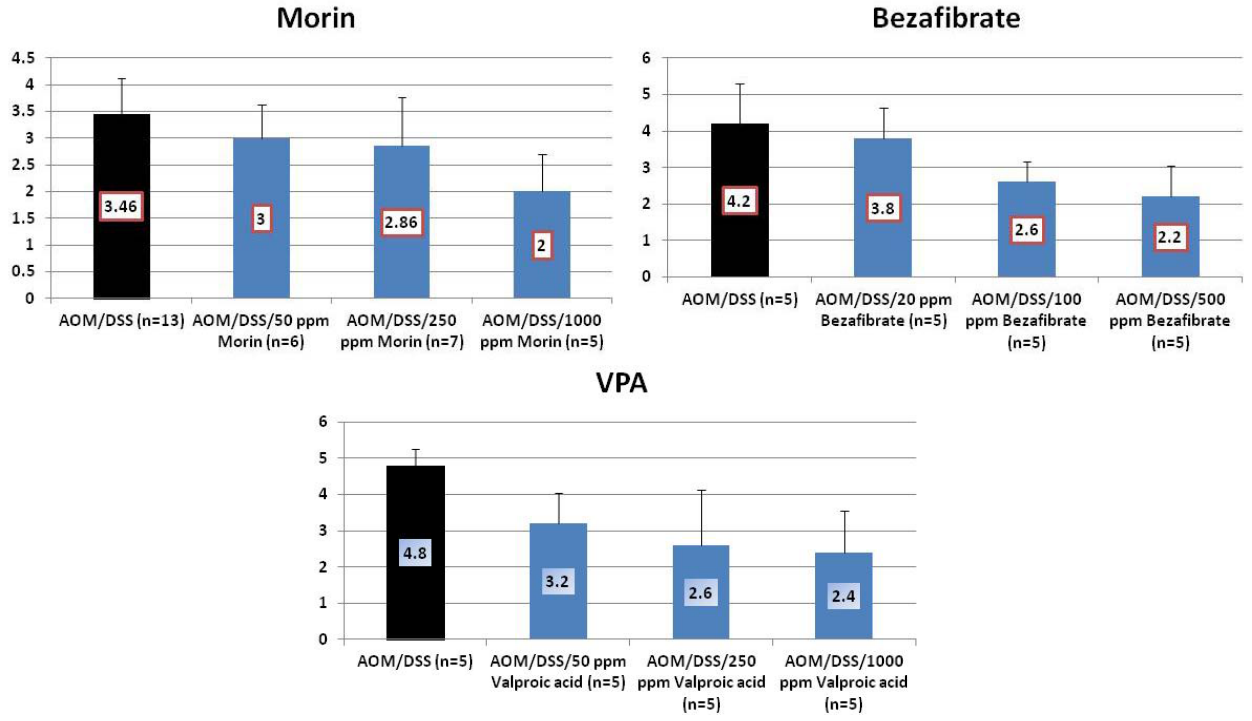
Figure 11. mRNA expression of IL-1 β in the colorectum of mice or rats from the morin, bezafibrate, and VPA studies.